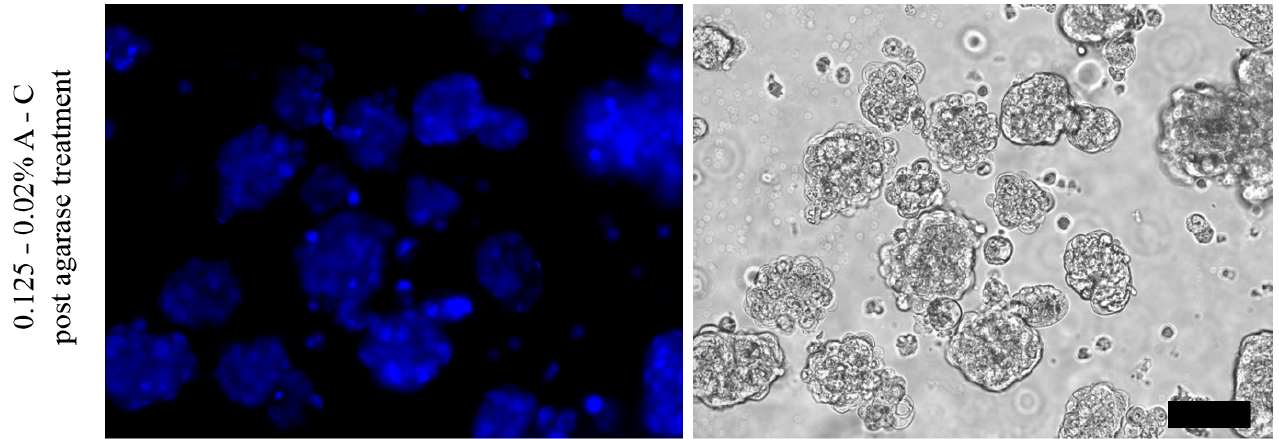
Figure 9. Optical images of MCF-7 spheroids grown in the 0.25–0.02% (upper panels) and 0.125–0.02% (lower panels) A-C hydrogels, recovered after agarase treatment, fixed and stained with DAPI. Scale bars correspond to 100 µm